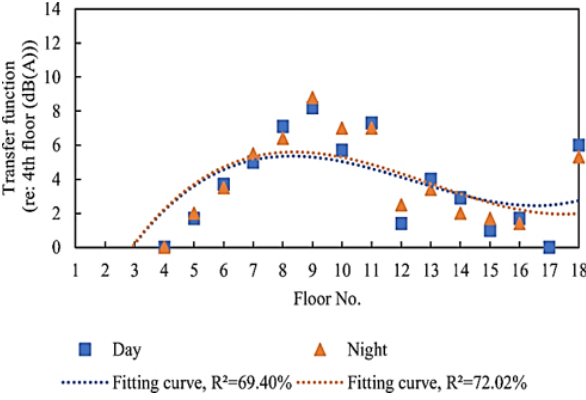
Figure 2: Transfer function between each floor and 2nd floor (build- ing B), (figure taken out of [21])